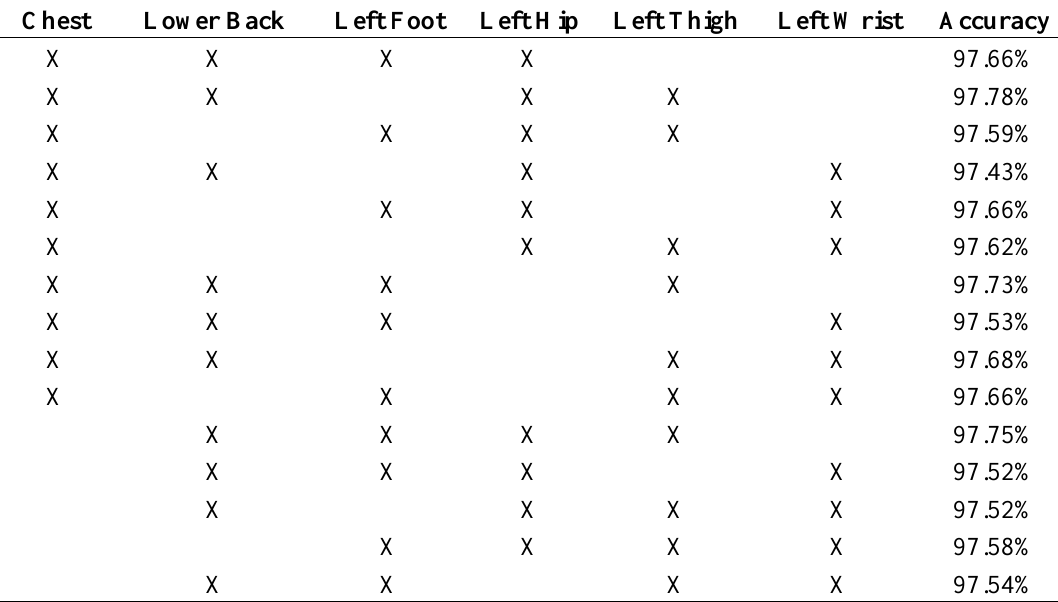
Table 8. Percentage correctly classified instances for 4 location combinations.